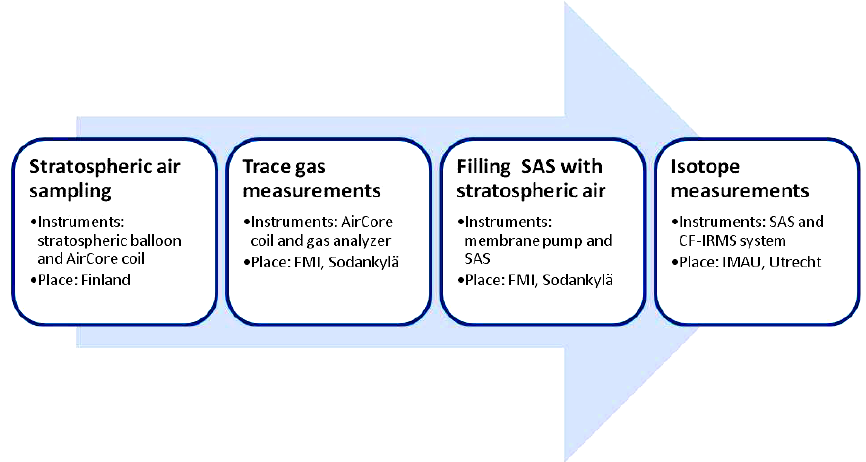
Figure 1. A schematic diagram showing the overall procedure described in this work, from AirCore sampling on the site to IRMS analysis in laboratory.